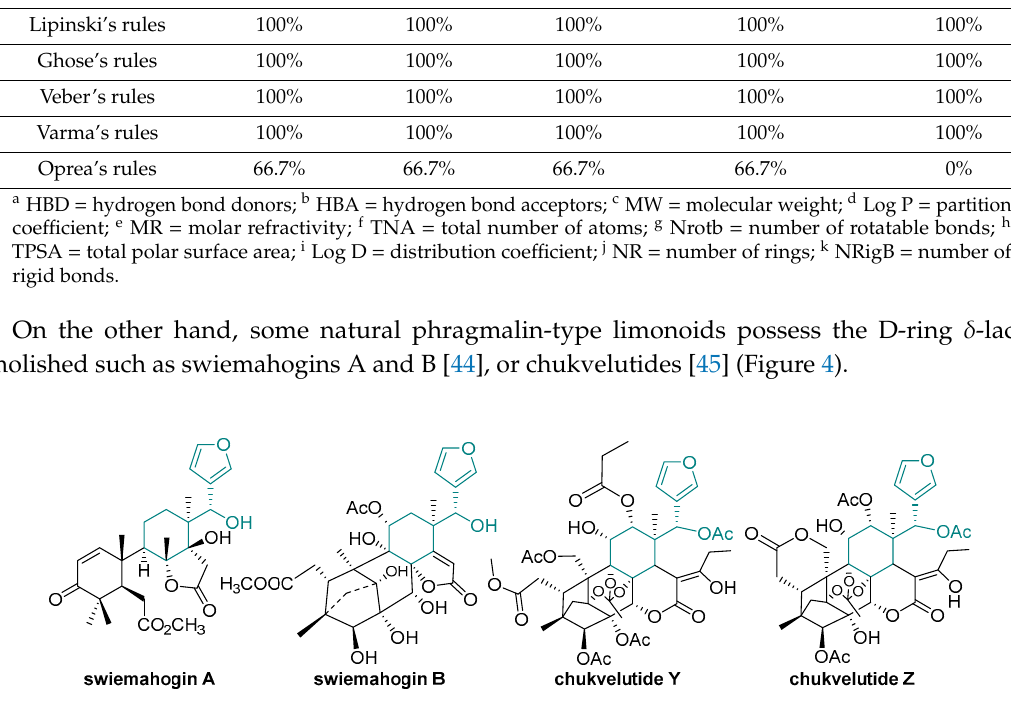
Figure 4. Chemical structures of some phragmalin-type limonoids.